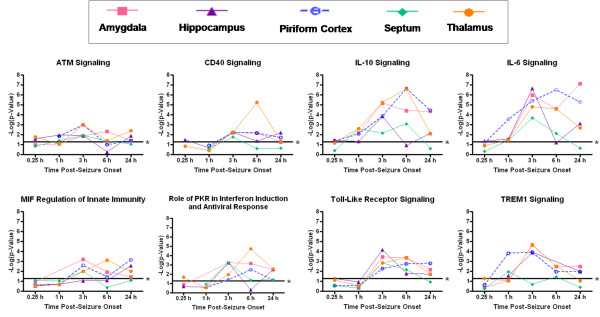
Canonical pathways significantly altered in all five brain regions of sarin-exposed seizing animals. A one-way ANOVA was performed to identify genes significantly changed in each brain region at each time point based on exposure (sarin vs. saline). The p-value and geometric fold change for each probeset ID were imported into IPA to identify the biological functions and canonical pathways most significantly affected by sarin-induced seizure at each time point. The top 800 genes that met the p-value cutoff (≤ 0.05) and were associated with a canonical pathway in the IPA Knowledge Base were considered for the analysis. The significance of the association between the dataset and the canonical pathway was calculated using Fisher's exact test. The -log of the p-value is graphed for each time point, with a threshold of 0.05 (or 1.3 when expressed as -log(p-value)) marked by an asterisk. The range of the y-axis was formatted the same to facilitate comparison across all the graphs in the figure.